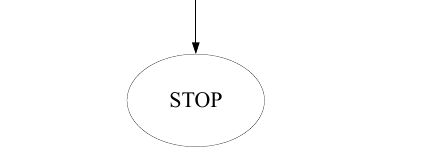
Figure 8. Optimal delivery plan process (Source: Self Edit).